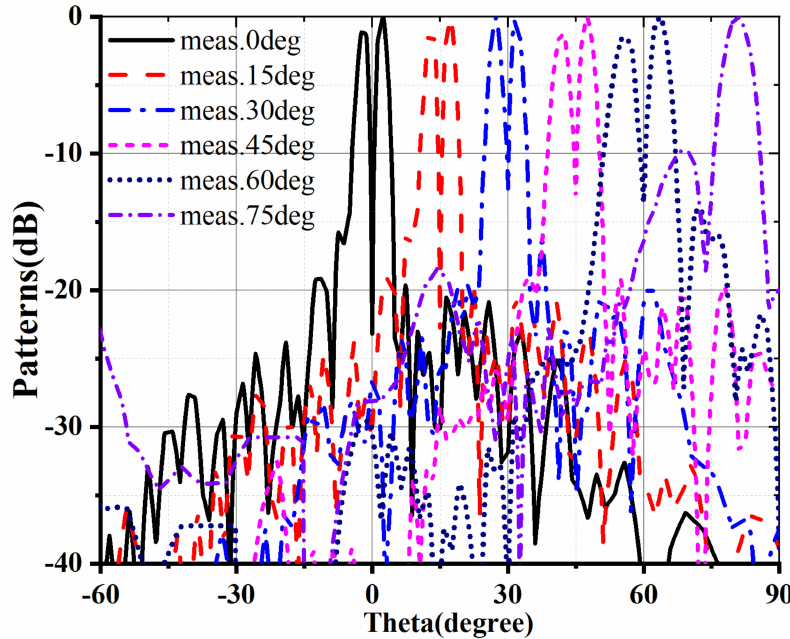
Figure 7. Measured far-field data for beam scanning of OAM in XOZ plane with di ff erent angles at 0 ◦ , 15 ◦ , 30 ◦ , 45 ◦ , 60 ◦ , 75 ◦ .